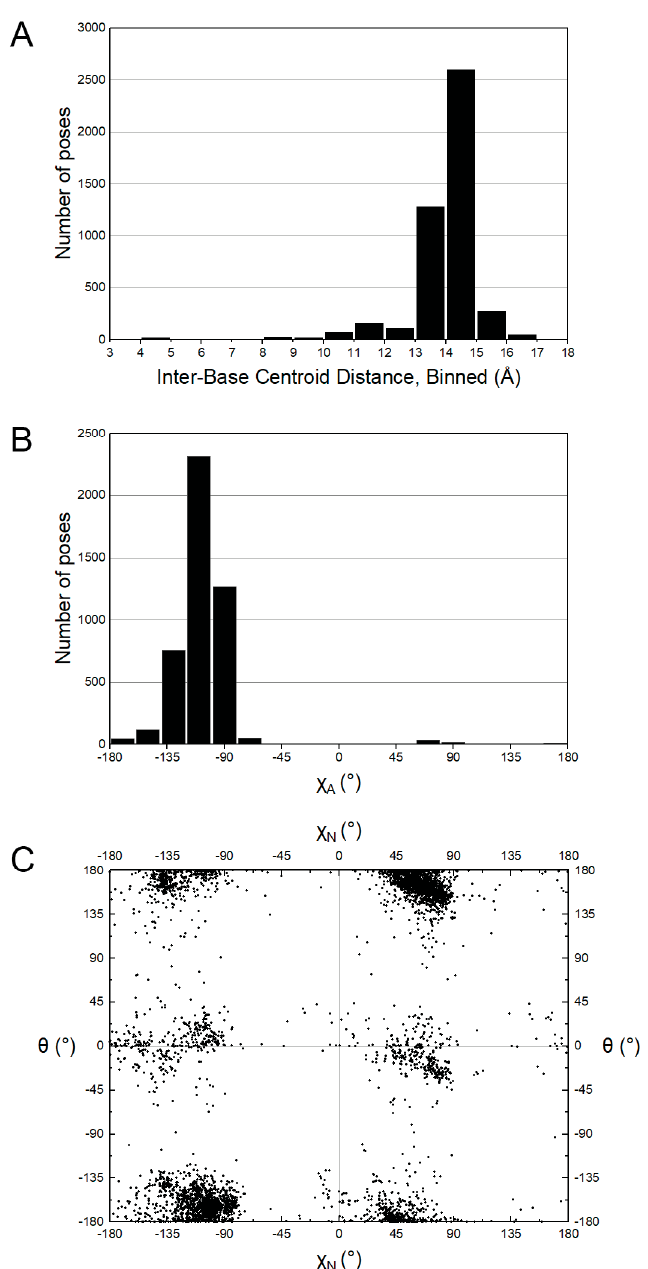
Figure 8. Conformations of protein-bound NAD(H) from PDB. ( A ) Histogram of inter-base centroid–centroid distance. ( B ) Histogram of the adenosine glycosidic bond dihedral angle ( χ A ). ( C ) Scatter plot of the nicotinamide amide dihedral angle ( θ ) versus nicotinamide ribose glycosidic bond dihedral angle ( χ N